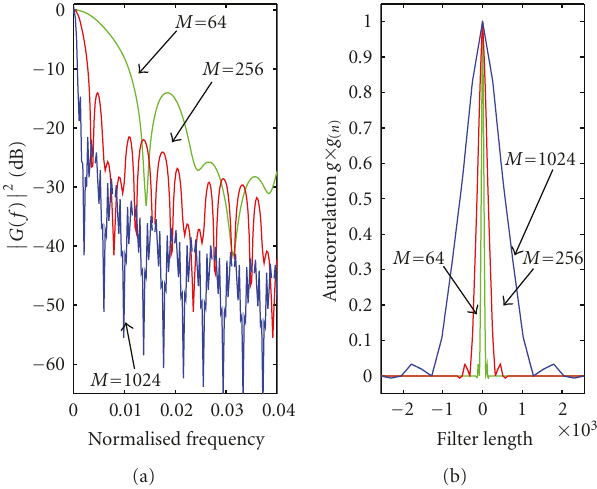
Figure 11: Frequency response and pulse autocorrelation for parameters M 0 = 4, N 0 = 5, and L f = 2 N .